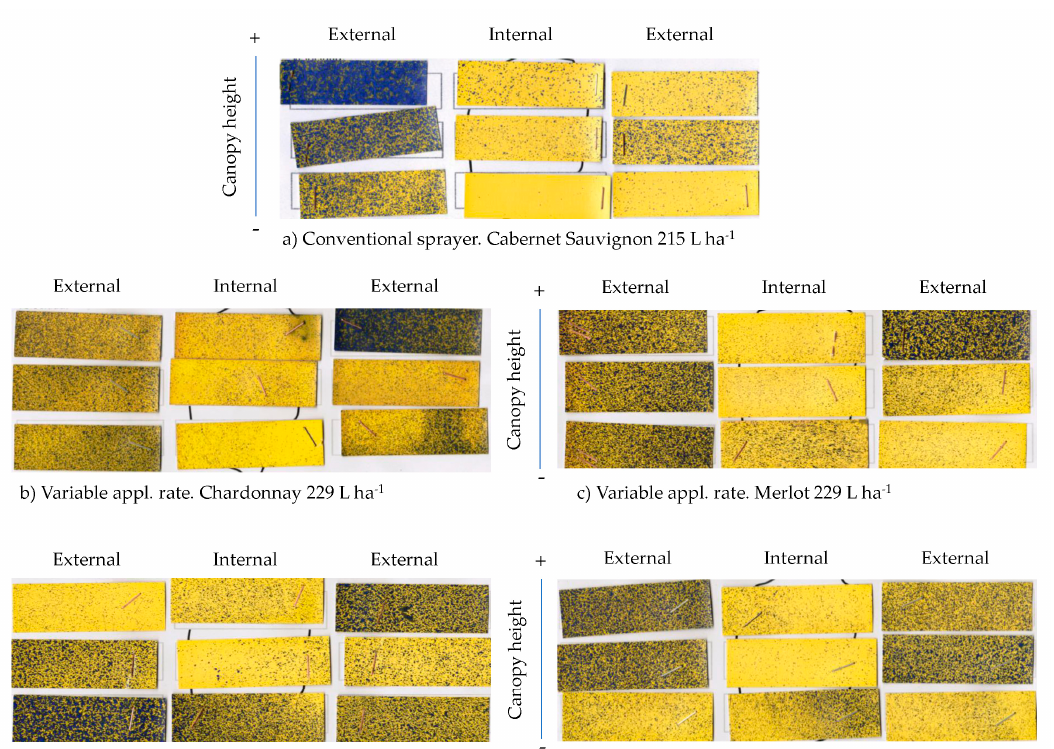
Figure 9. Percentage of water sensitive papers coverage obtained each vigor. Mean of the parcels ± SEM.